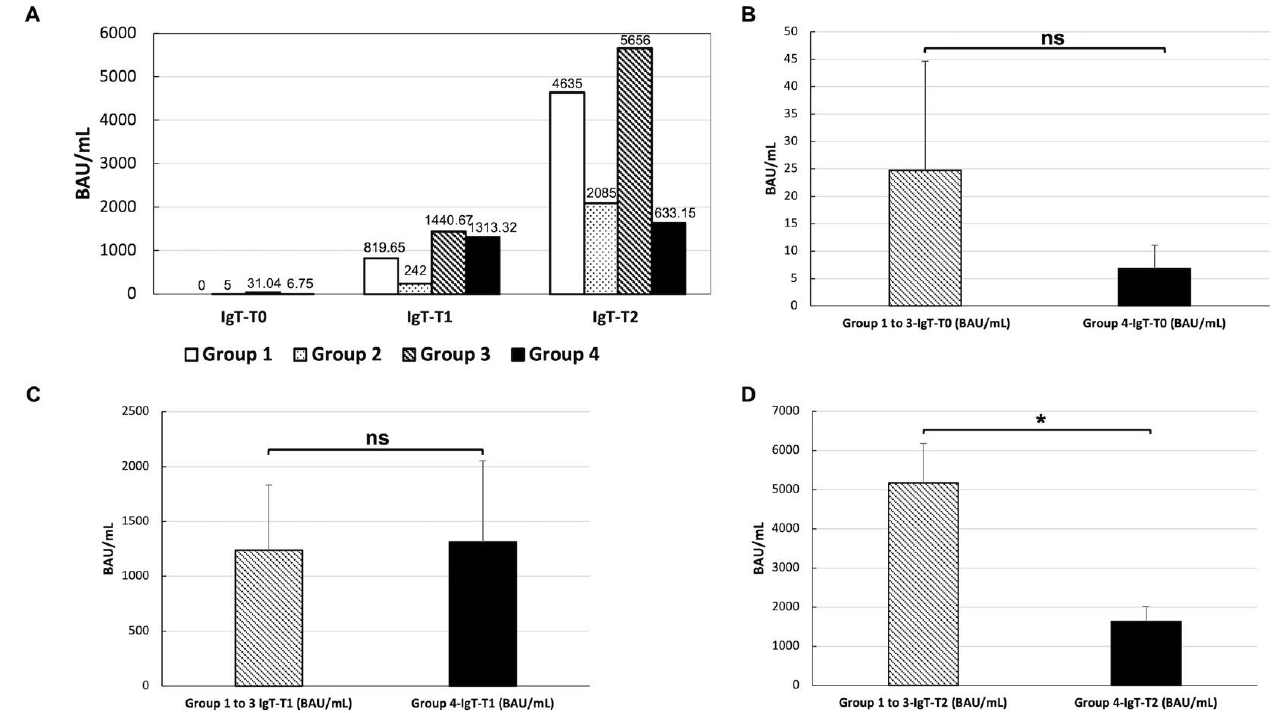
Figure 4. Anti-SARS-CoV-2-IgG levels at T0, T1, and T2 in patients treated with different immunosuppression levels ( A ). Group 1: no therapy; group 2: low-level immunosuppression (i.e., hydroxychloroquine alone); group 3: medium-level immunosuppression (i.e., azathioprine, methotrexate, prednisone < 20 mg/die, ciclosporin, belimumab given in monotherapy); and group 4: high-level immunosuppression (i.e., prednisone > 20 mg/die, mycophenolate mofetil, cyclophosphamide, combination therapy). Comparison between anti-SARS-CoV-2-IgG levels between anti-SARS-CoV-2-IgG levels between patients with no treatment to medium treatment (i.e., group 1 to 3) and with high treatment (i.e., group 4). No significant difference (ns) was found at T0 [t(19) = 0.84; p = 0.41] ( B ) nor at T1 [t(36 ) = −0 .22; p = 0.82]] ( C ) between the two groups of patients. A significant difference between the two groups (*) was found at T2 [t(22) = 3.41 ; p < 0.002], showing higher anti-SARS-CoV-2-IgG levels for the patients with no treatment to medium treatment (i.e., group 1 to 3) compared with patients with high treatment ( D ).